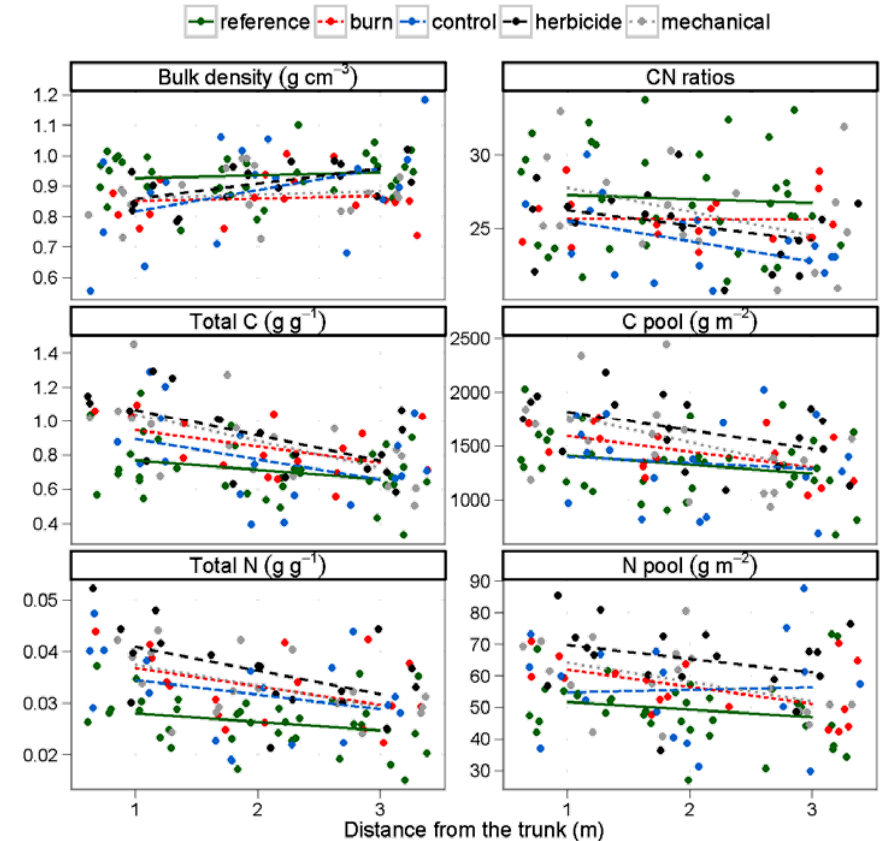
Figure 1. Relationships between soil properties and distance from the trunk of longleaf pine ( Pinus palustris ) trees (n = 36) at Eglin Air Force Base (EAFB), Florida. Please note that jitter points were used to ovoid overplotting. Carbon and nitrogen are presented on a dry soil mass basis ( i.e. , g g − 1 ) and volume basis ( i.e. , g m − 2